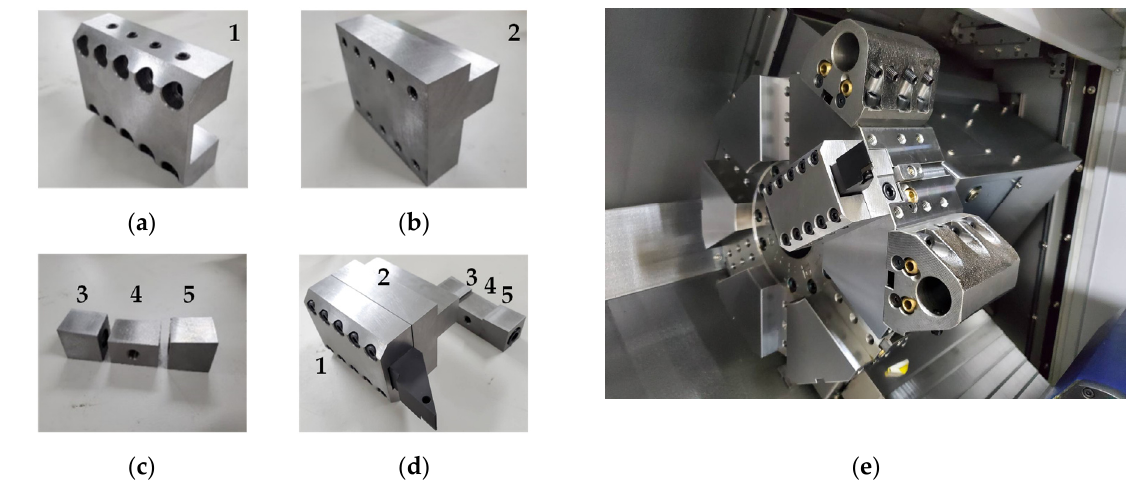
Figure 4. The stress field of the smart tool holder subject to the cutting force based on finite element simulation: ( a ) the fixed boundaries being shown on the blue surfaces; ( b ) the stress field of the combination of the turning tool and the smart tool holder; and ( c ) the backside and front-side views of the stress field of the smart tool holder.